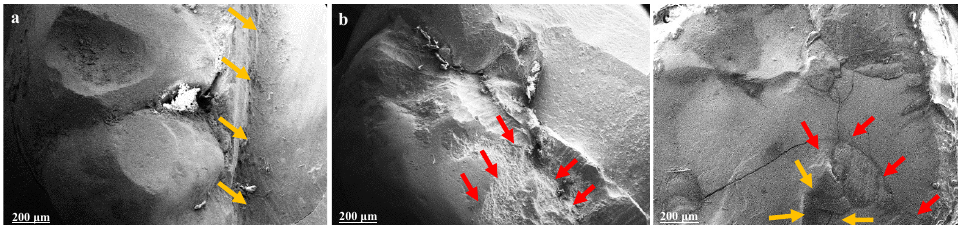
Figure 5. Fracture patterns under SEM: ( a ) Adhesive, with 31× magnifications, indicated by yellow arrow; ( b ) Cohesive, with 32× magnifications, indicated by red arrow; ( c ) Mixed, with 30× magnifications.